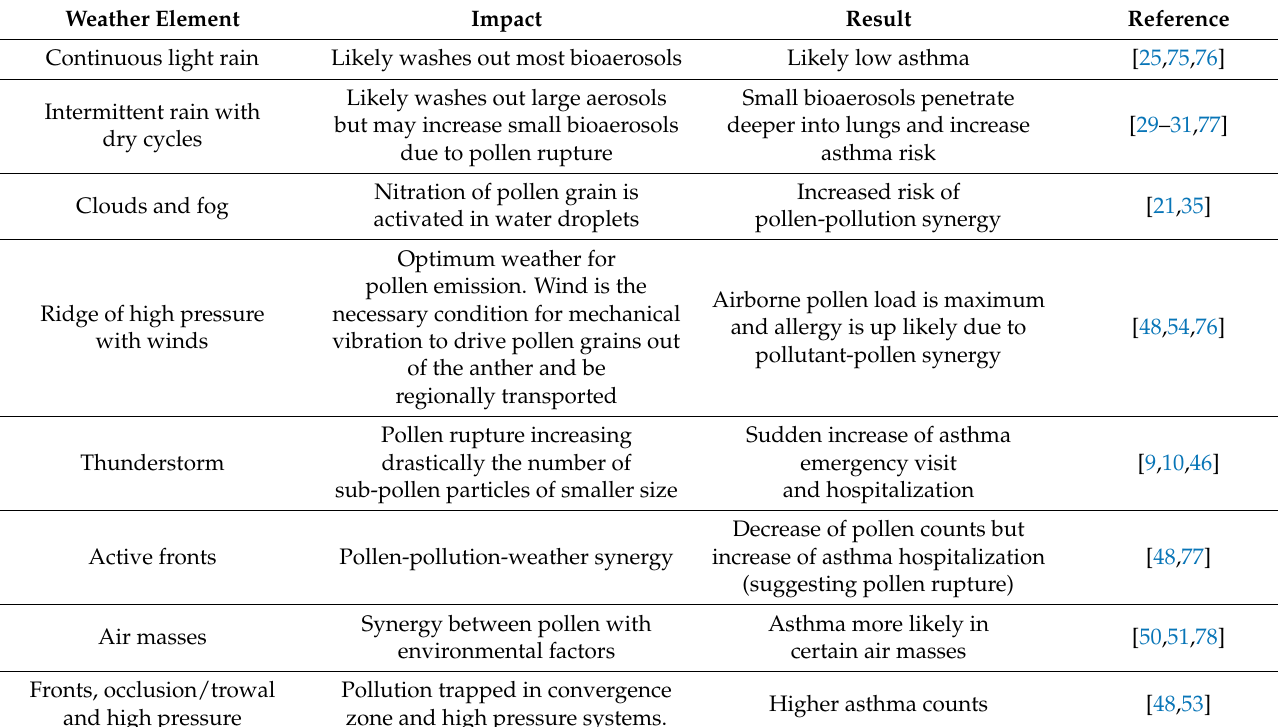
Table 1. Weather elements and their documented or potential impacts on asthma (from